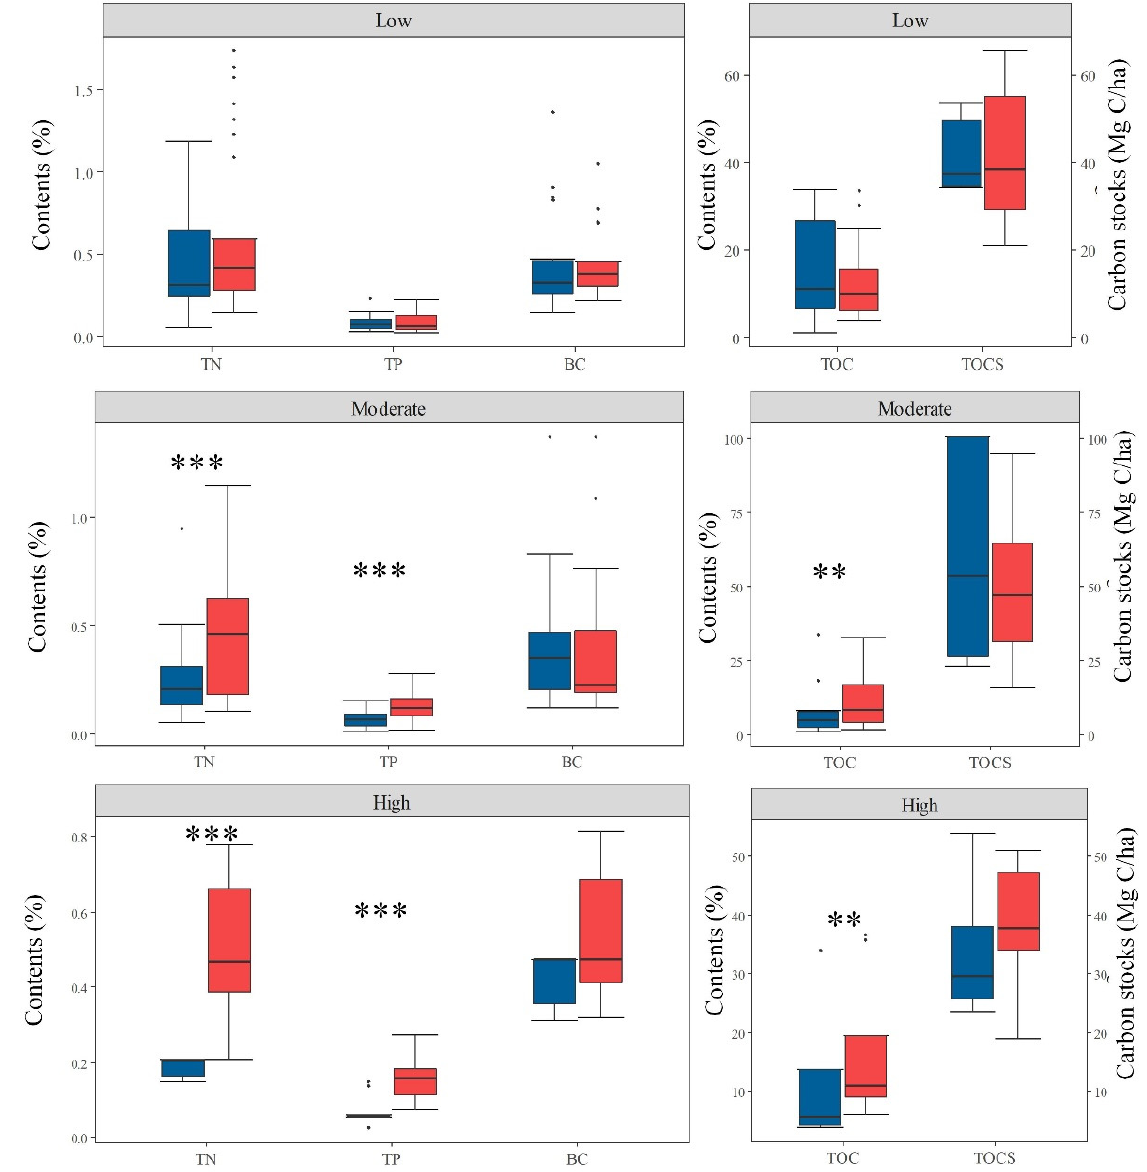
Figure 4. Boxplots of soil elements in contents and TOCS before and after fires under three levels of fire severity ( p < 0.05 **, p < 0.01